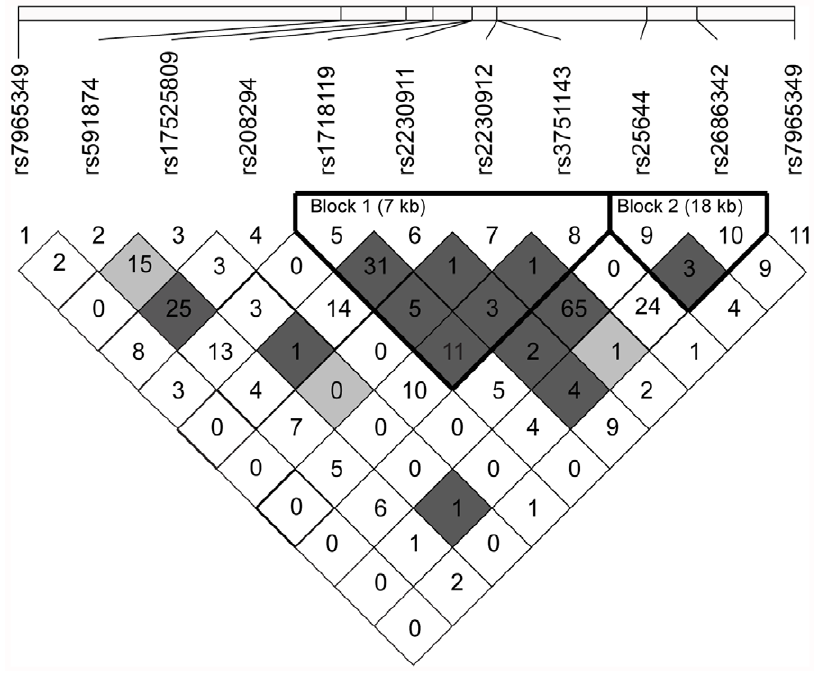
Figure 2. Patterns of linkage disequilibrium within P2RX7 , OASL , CAMKK2 and P2RX4 . Shown are r 2 -values between polymorphic loci in the LSR sample. SNPs lying within blocks are depicted in bold type. Dark grey background: strong linkage; light grey background: uninformative; white background: recombination.